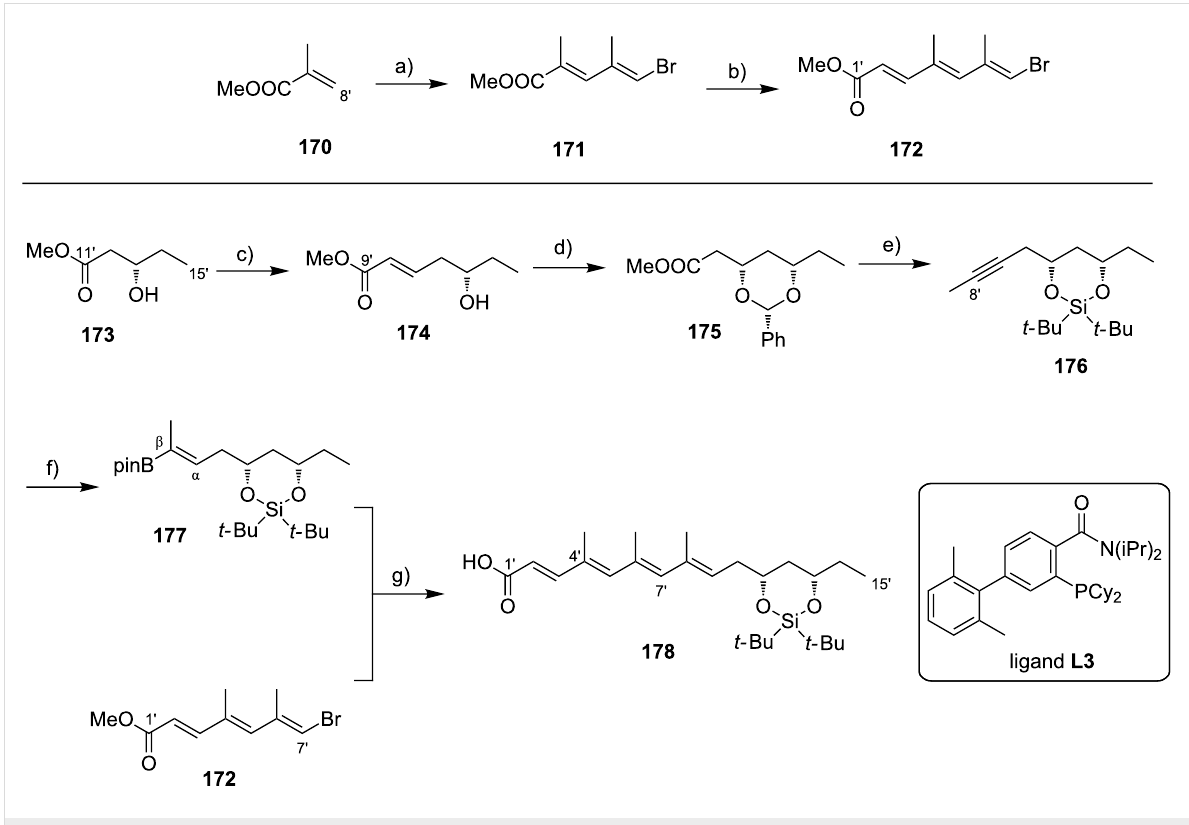
Scheme 28: Wang and Dai’s synthesis of the mycolactone E tetraenoate side chain. Reagents and conditions: a) (i) Br 2 , CCl 4 , rt, then DBU, CCl 4 , rt; (ii)